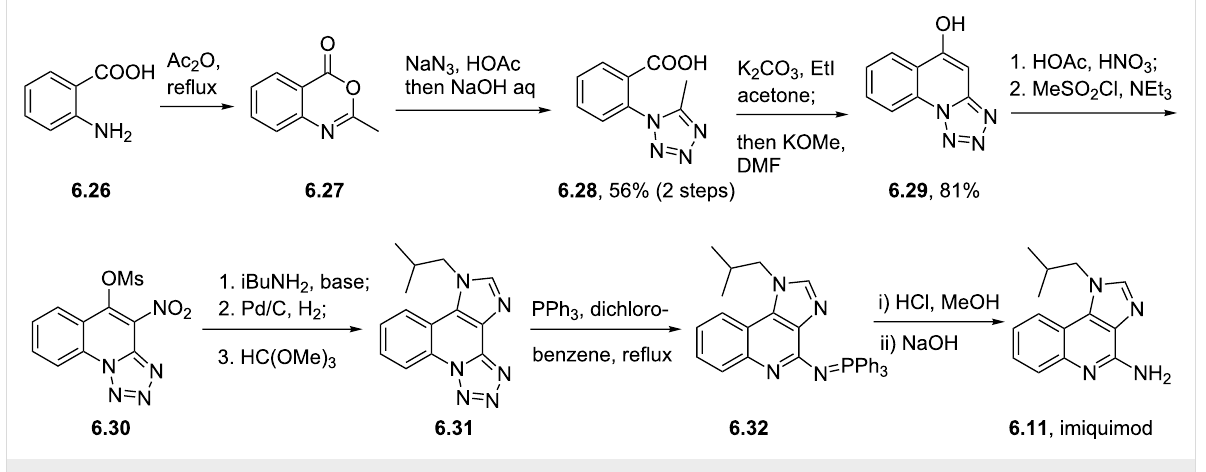
obtained. Esterification of the carboxylic acid followed by cyclisation under more basic reaction conditions affords the corresponding tetrazoloquinoline 6.29 . Further sequential manipulations can then be used to install the two nitrogen atoms needed for the imidazole ring. Neatly the tetrazole unit when treated with triphenylphosphine generates an intermediate iminophosphorane 6.32 via a retro-Staudinger reaction furnishing imiquimod upon work-up. While this route is synthetically very interesting it is unlikely to be amenable for transfer to bulk scale production because of the potential explo- sive nature of the reactive tetrazole